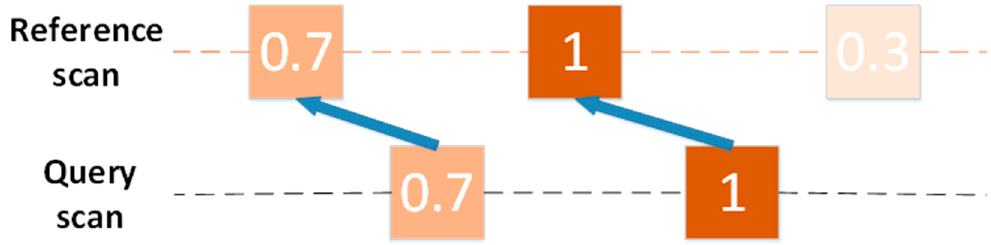
Figure 7. Scanning point cloud of two adjacent frames. The color and number of the square indicate that the target has different RCS. In the end, the only correct matching relationship will be obtained, as shown by the blue arrow.